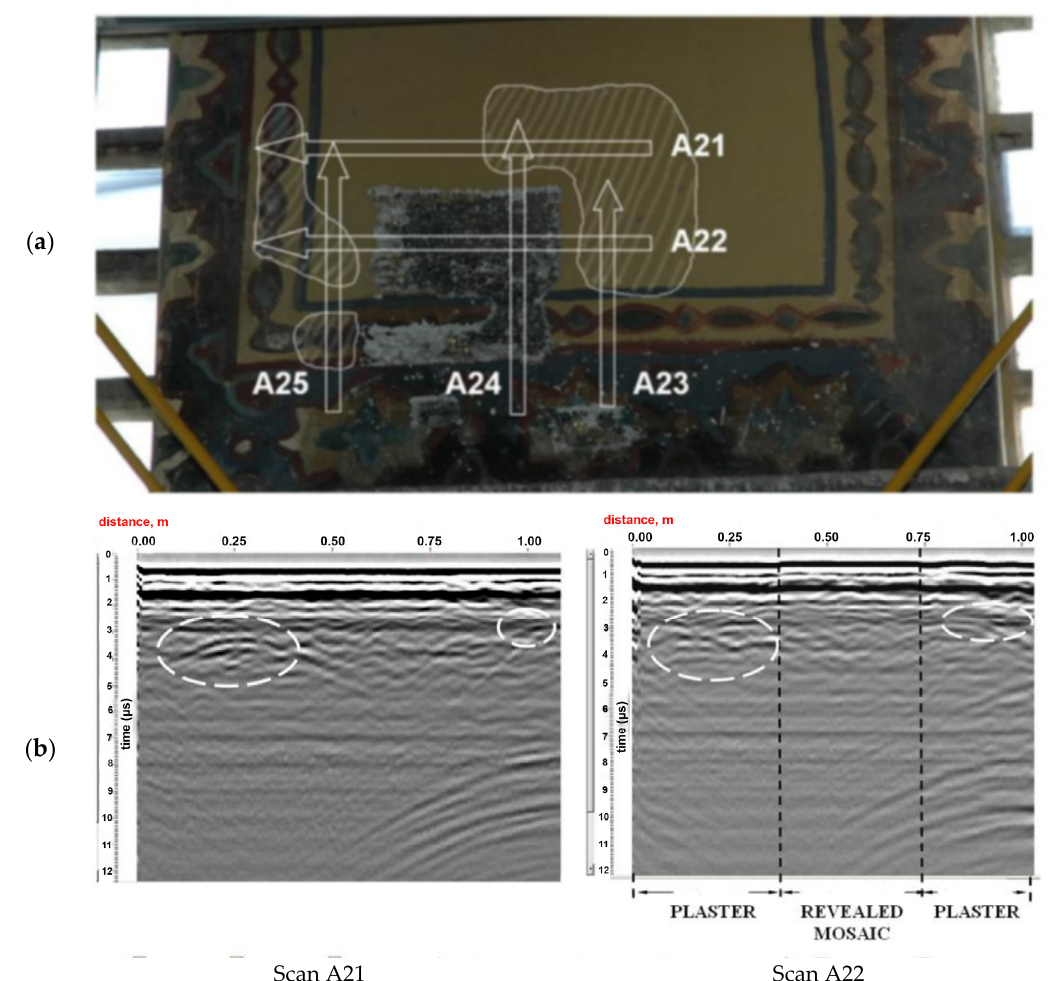
Figure 2. Ground-penetrating radar (GPR) results on wall mosaics in Hagia Sophia (Istanbul, Turkey): ( a ) examined area of a plastered surface; ( b ) GPR scans, the highlighted ripples reveal the presence of plastered mosaics. After Moropolou et al. [62] (reprinted with copyright permission).